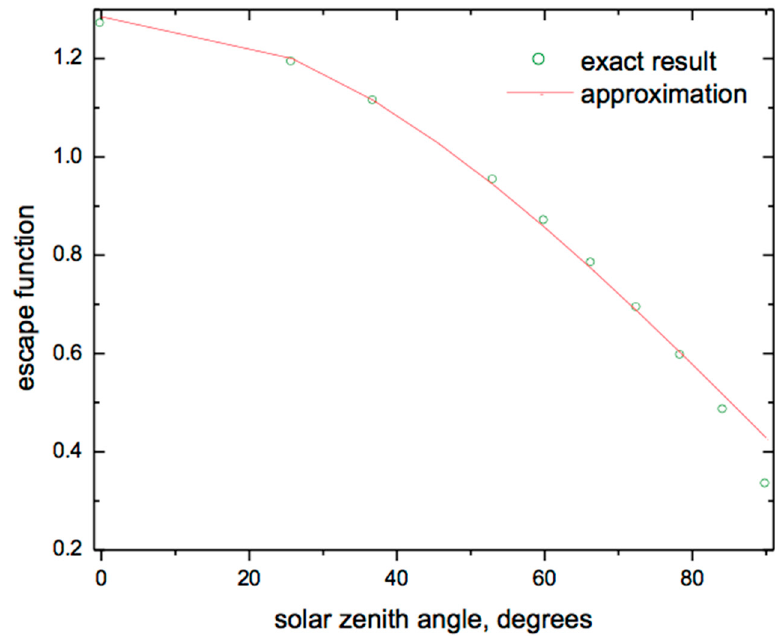
Remote Sens. 2019 , 11 , x FOR PEER REVIEW Figure 1. The intercomparison of escape functions calculated using exact theory and Equation (5).